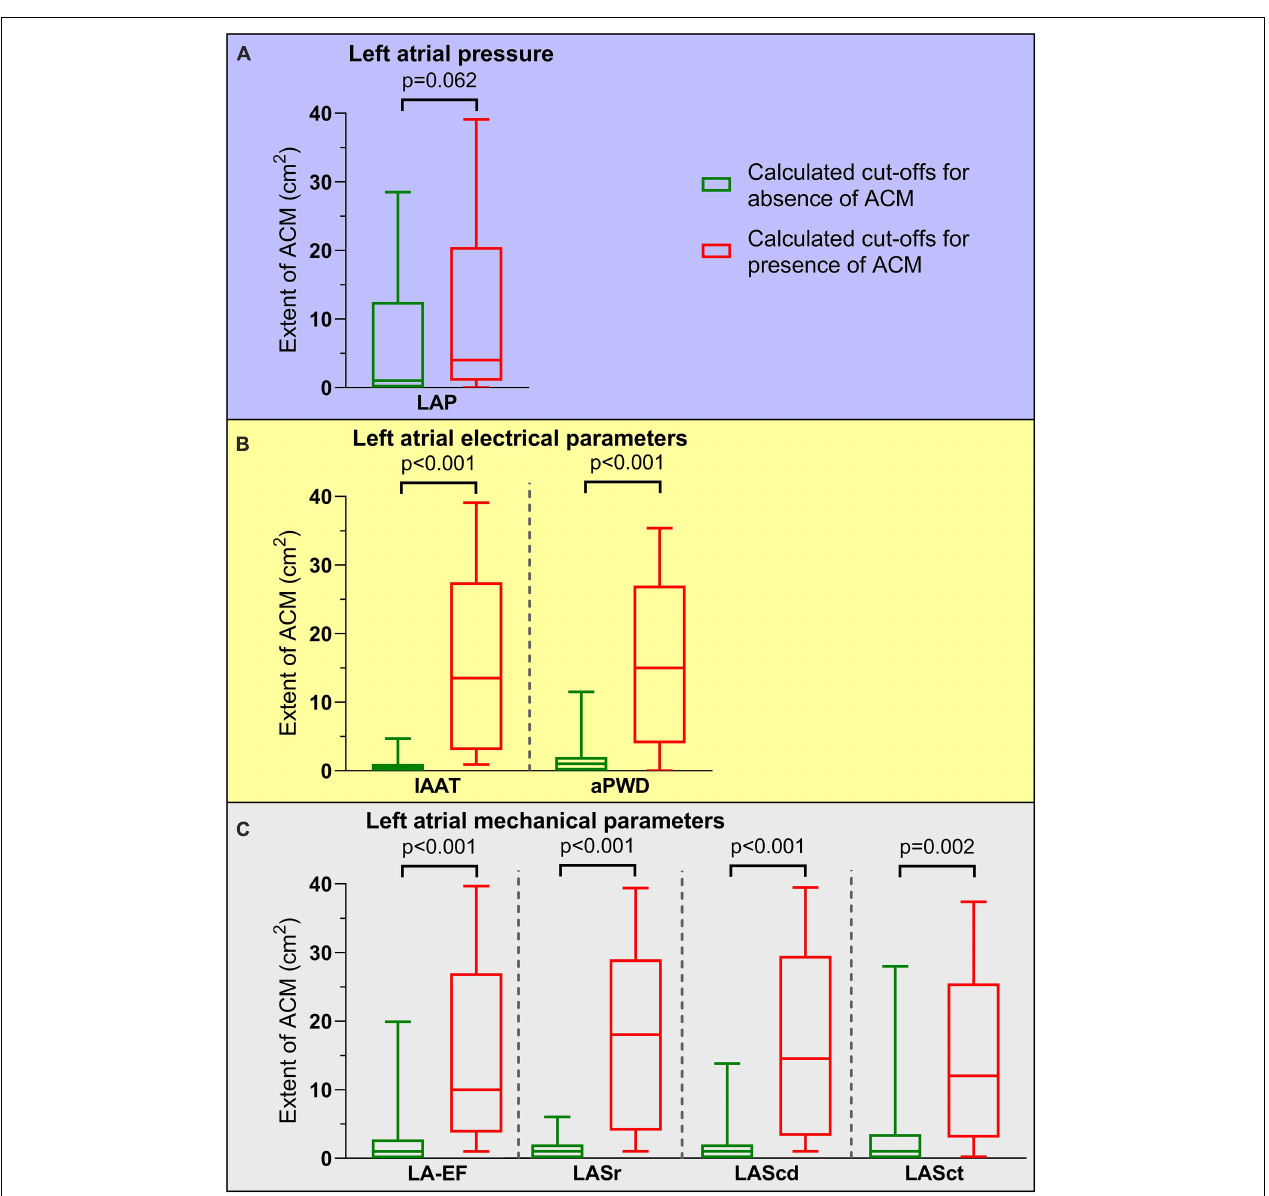
FIGURE 4 | Association of pathological cut-off values for left atrial function and atrial cardiomyopathy (ACM) extent. ACM extent for patients with calculated cut-off values for presence of ACM (red boxes and whiskers) compared to cut-off values for absence of ACM (green boxes and whiskers) are depicted. With the exception of left atrial pressure [LAP, (A) ], all left atrial electrical [invasive atrial activation time (IAAT), amplified p-wave duration (aPWD), (B) ] and left atrial mechanical parameters [left atrial emptying fraction (LA-EF), left atrial strain during reservoir phase (LASr), conduit phase (LAScd), and contraction phase (LASct), (C) ] allowed significant differentiation between high and low ACM extent: 4.3 (0.7–20.6) cm 2 versus 1.1 (0.2–12.2) cm 2 for LAP, 13.1 (3.2–27.6) cm 2 versus 0.5 (0–1.2) cm 2 for IAAT, 14.7 (4.0–26.9) cm 2 versus 0.8 (0.2–1.8) cm 2 for aPWD, 9.6 (3.8–26.6) cm 2 versus 0.7 (0–2.8) cm 2 for LA-EF, 17.7 (4.1–29.1) cm 2 versus 0.5 (0.1–1.5) cm